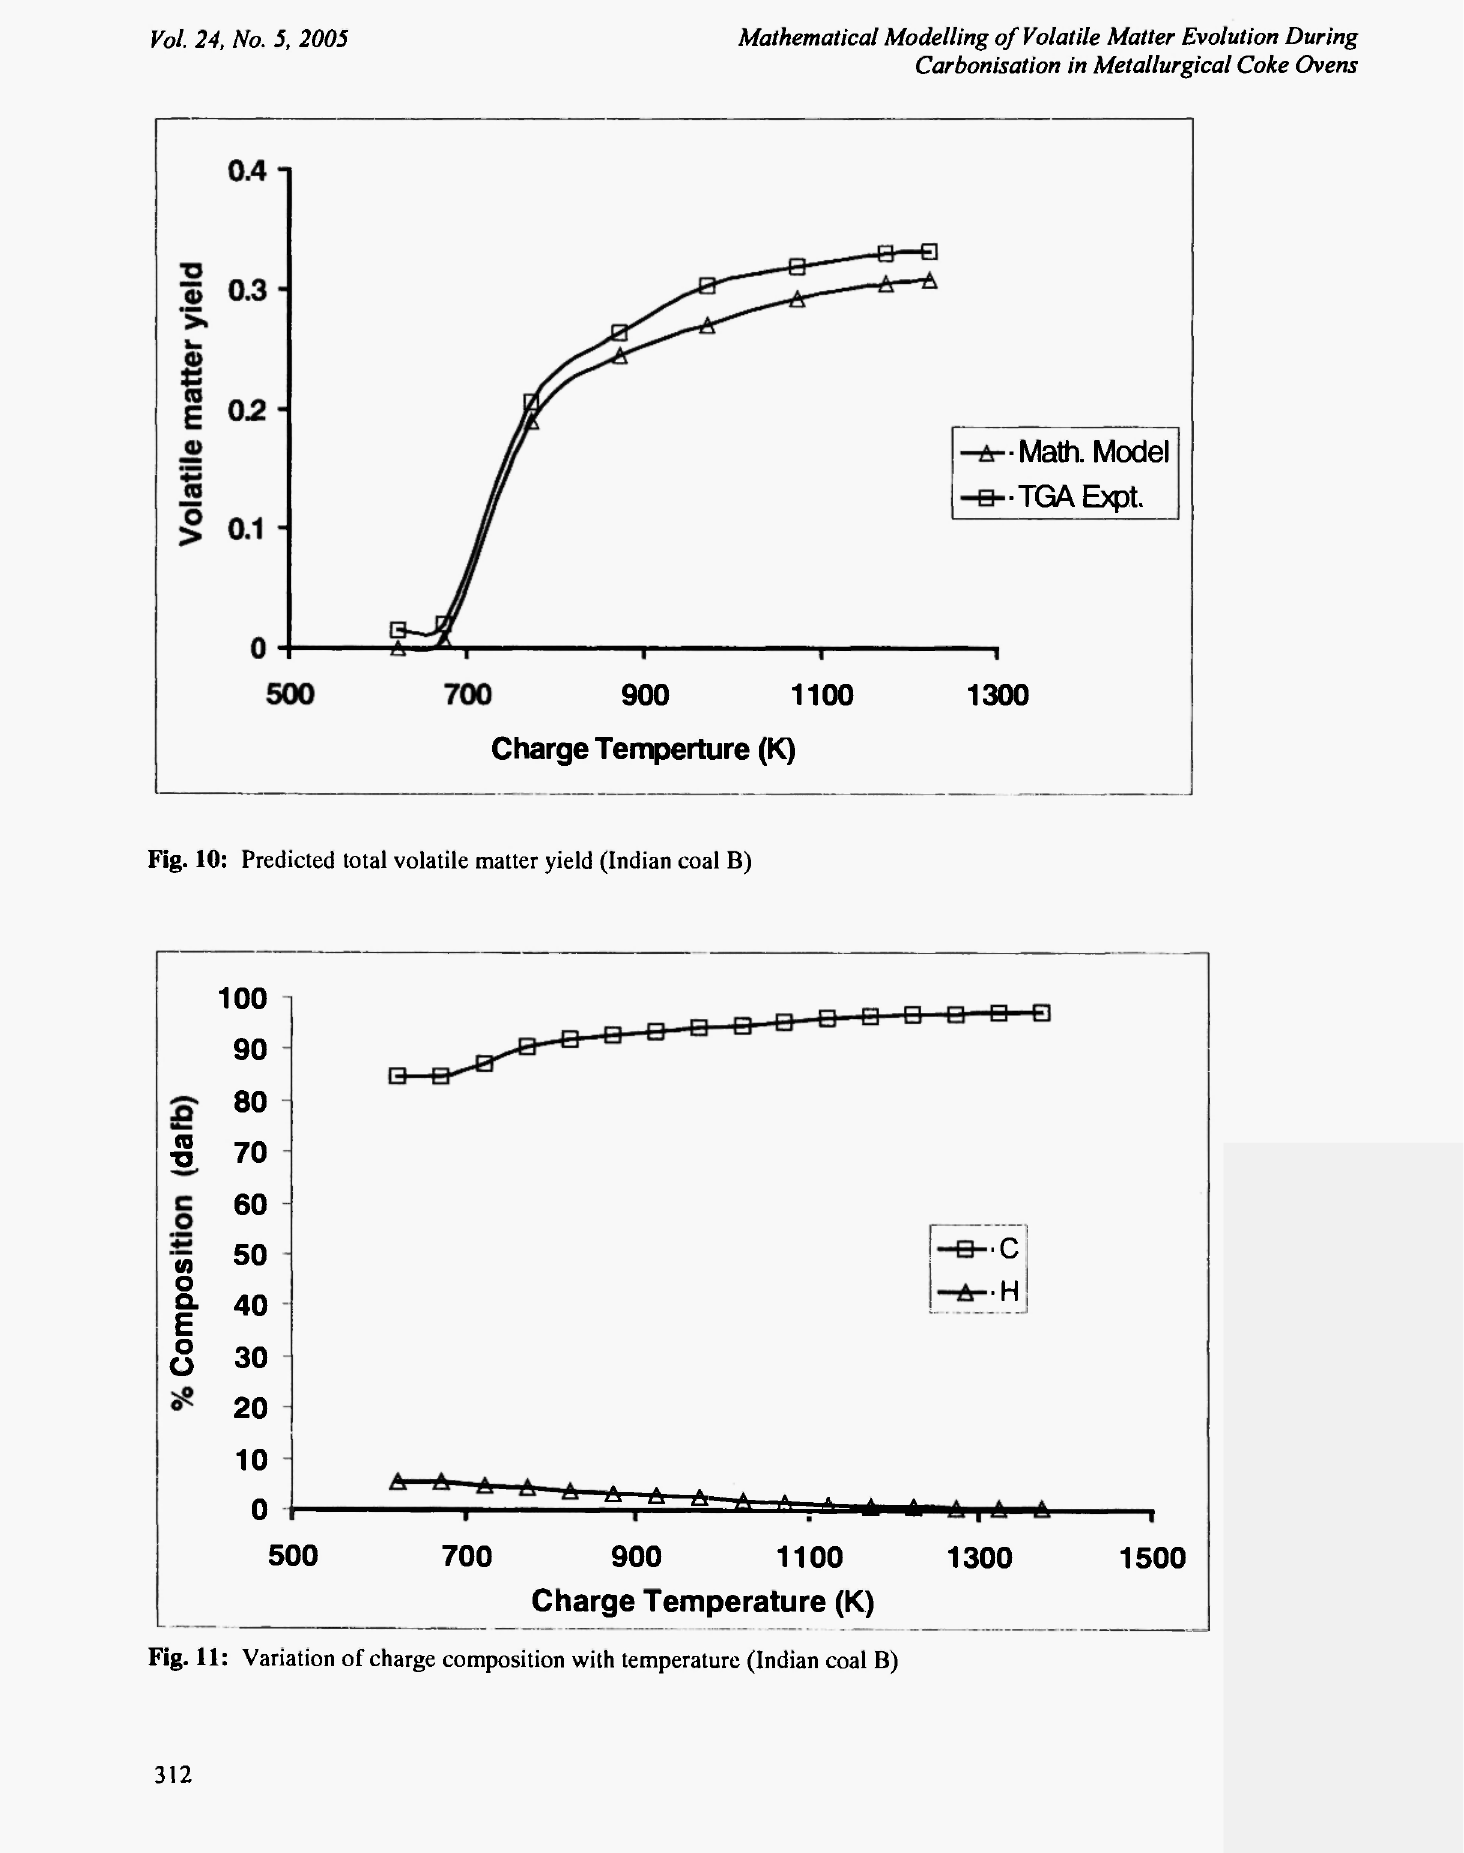
Fig. 11: Variation of charge composition with temperature (Indian coal B)